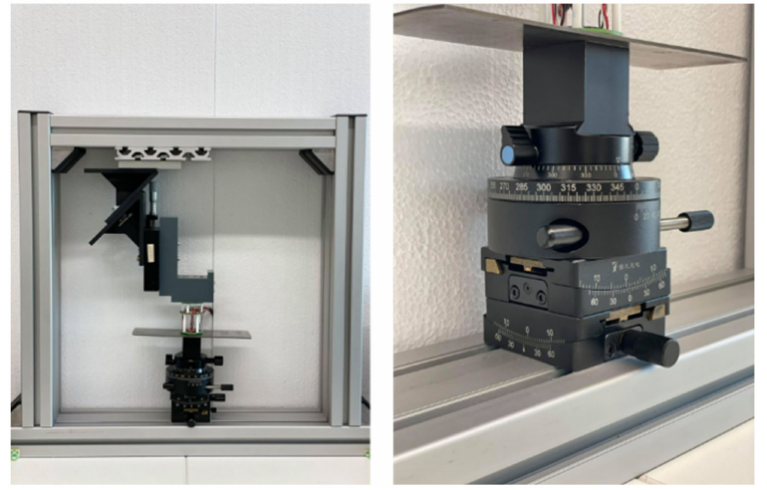
Figure 4. Experimental setup with a rotating table, two tilting tables, and slider to adjust the material being